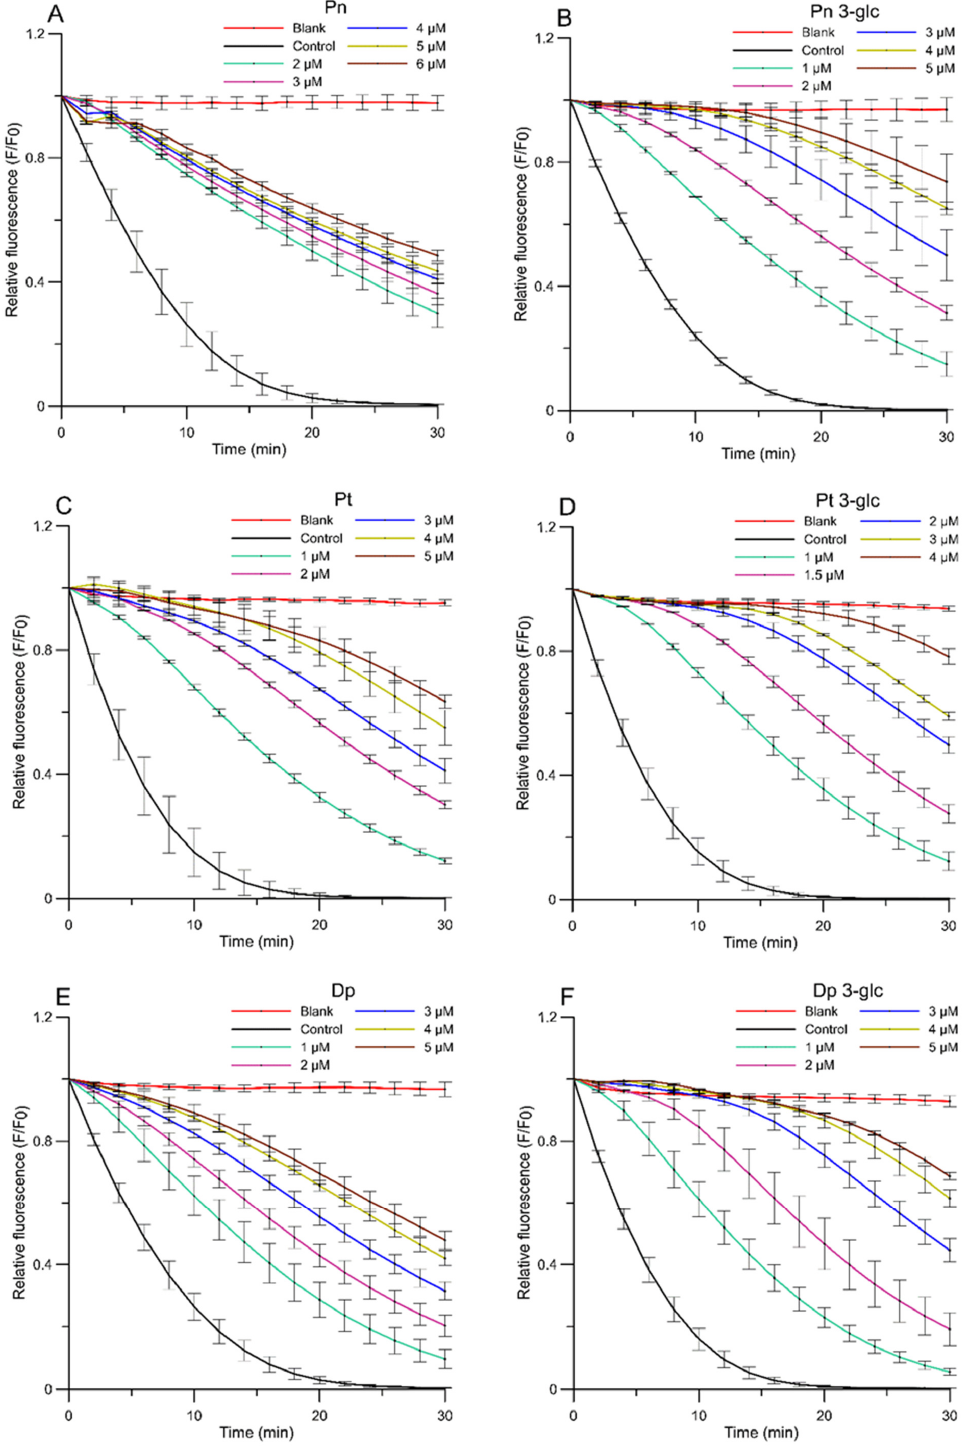
Figure 1. Relative fluorescence intensity of DPH-PA probe as a function of time of oxidation a lipid mimic membrane for AAPH • radicals in the presence of anthocyanins at selected concentrations. ( A ) peonidin, ( B ) peonidin 3- O -glucoside, ( C ) petunidin, ( D ) petunidin 3- O -glucoside, ( E ) delphinidin, ( F ) delphinidin 3- O -glucoside. The relative change in fluorescence intensity F/F 0 is a measure of the degree of lipid peroxidation. (F 0 —fluorescence in the control sample (oxidized by AAPH • without anthocyanins), F—fluore-scence of samples in the presence of anthocyanins). Blank sample—not oxidized by AAPH • and without